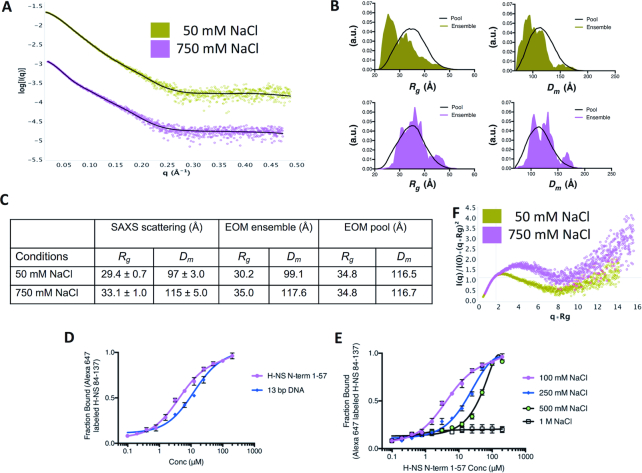
H-NSΔs2 adopts a relatively compact conformation in vitro. (A) Experimental H-NSΔs2 SAXS patterns recorded at 50 mM NaCl (green) and 750 mM NaCl (pink). Calculated SAXS pattern from ensemble models are shown in black. The corresponding Guinier plots are shown in Supplementary Figure S8. (B) Histogram of Rg and Dm for pool (black line) and selected ensemble models (olive for 50 mM NaCl data, and pink for 750 mM NaCl data). a.u: arbitrary units. The corresponding ensemble models are shown in Supplementary Figure S8. (C) Rg and Dm values calculated from (A) and (B) are tabulated. (D) Interactions of fluorescently labeled H-NS84–137 with H-NS1–57 and 13bp DNA determined using MST. (E) Influence of NaCl on the H-NS84–137:H-NS1–57 interaction determined using MST. Data in (D, E) are means ± S.D., n = 3.